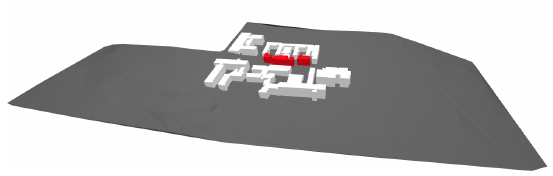
Figure 6. Visualisation result of above query via GQIS. Object painted in red belong to the ‘Red Center’